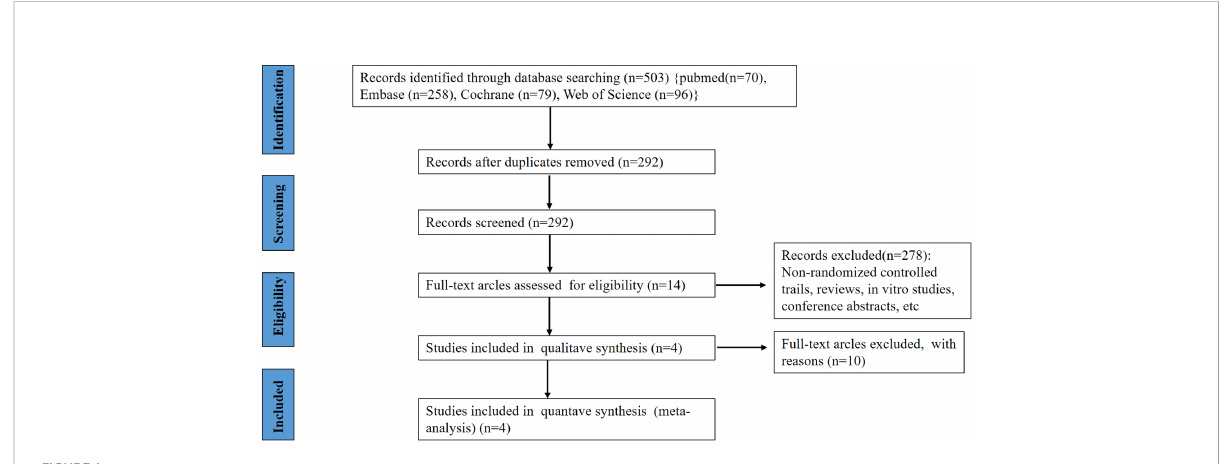
FIGURE 1 Flow chart of search strategy and study selection